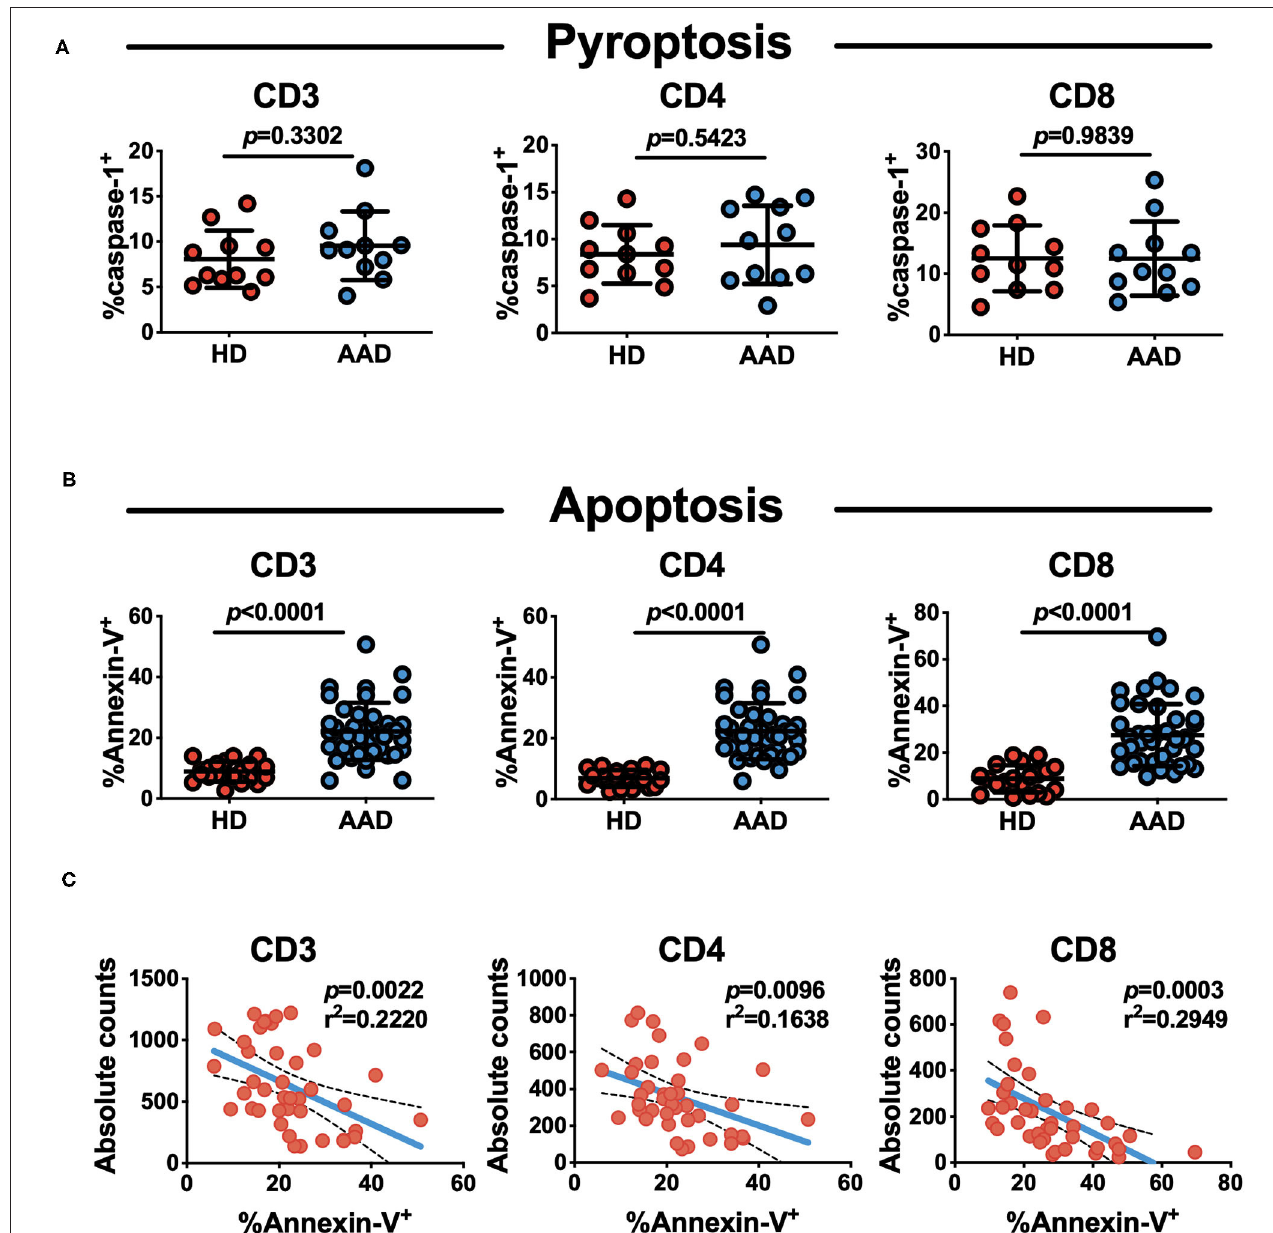
FIGURE 3 | Increased spontaneous apoptosis, not pyroptosis of T lymphocytes in AAD patients. (A) Analysis of pyroptosis status of lymphocyte subsets with flow cytometry ( n = 11). (B) Analysis of apoptosis status of lymphocyte subsets with flow cytometry. Mean ± SD comparing their rates on AAD patients ( n = 40) and HDs ( n = 20). (C) Correlation of absolute lymphocyte (CD3 + , CD4 + and CD8 + ) counts and apoptosis rate in AAD patients ( n =